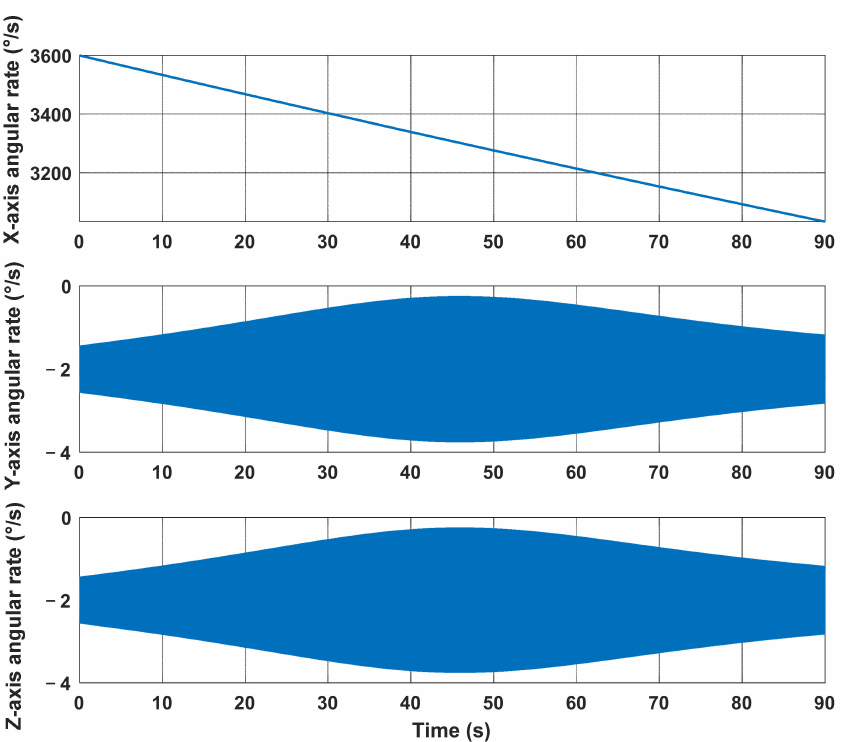
Figure 5. Three‑dimensional angular rate of projectile.